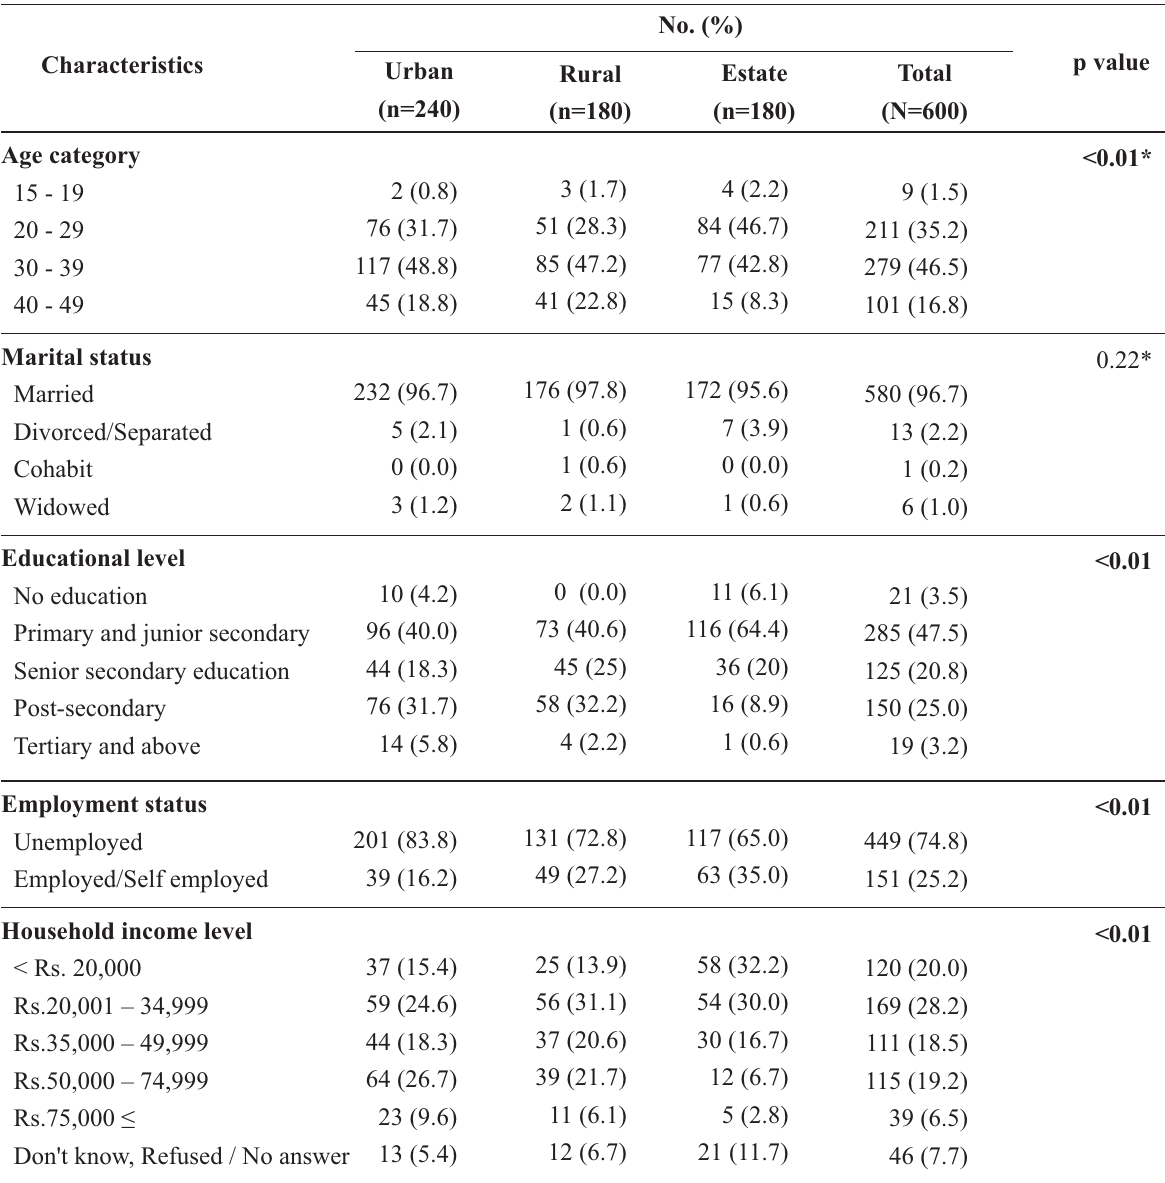
Table 1: Socio-demographic characteristics of participants of urban, rural and estate sectors